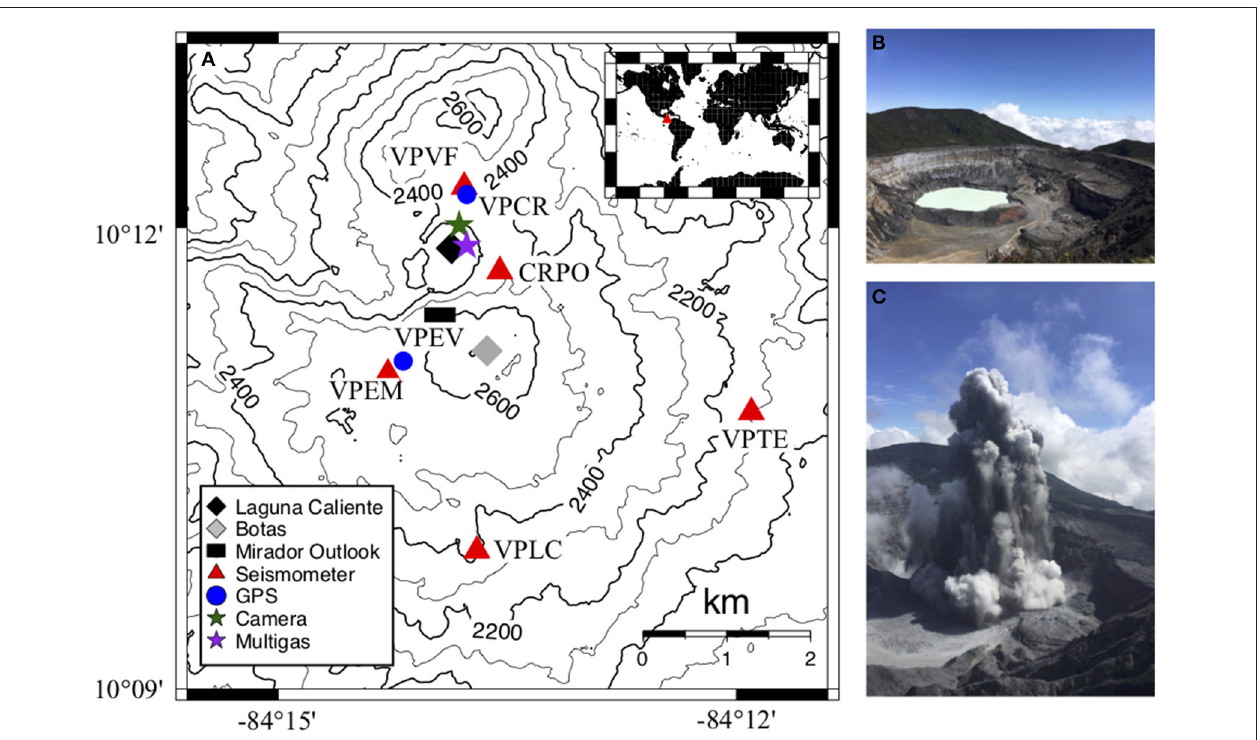
FIGURE 1 | (A) Topographical map showing the location of monitoring equipment before and after the 23 April 2017 large phreatomagmatic eruption at Poás (inset: Reference location of Costa Rica and Poás). The active crater (Laguna Caliente) is represented by the black diamond; and the dormant Botos crater is shown as a gray diamond to the south-east of the active crater. The Mirador outlook was the viewing station of the National Park for observation by tourists into the active crater, which was closed on 13 April 2017. Seismic and GPS stations are named as referenced in the text. CRPO, the Multi-GAS station (purple star) and the camera (green star) were all destroyed by eruptions in April 2017. (B) Photograph of Poás Laguna Caliente, 12 March 2017 from the Mirador before levels of unrest increased. Photo Credit: R. O. Salvage. (C) Example phreatomagmatic eruption at Poás crater, 19 April 2017 from the Mirador. Photo Credit: J. F.